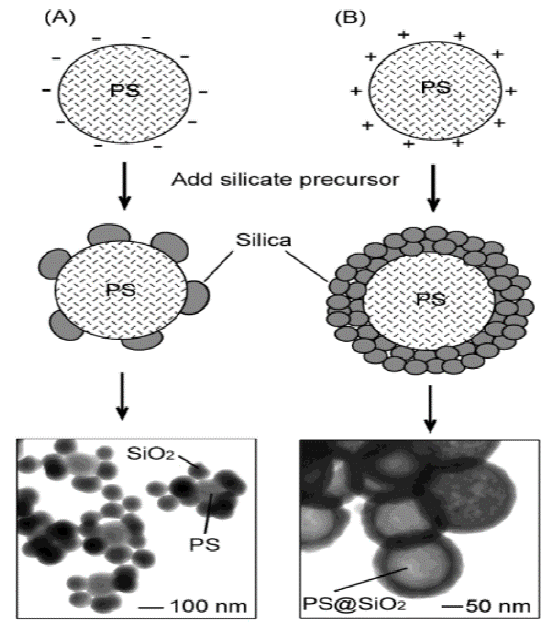
Figure 12. Schematic of the effect of the negative surface charge density on coating. ( a , c ) High surface charge density and ( b , d ) low surface charge density.